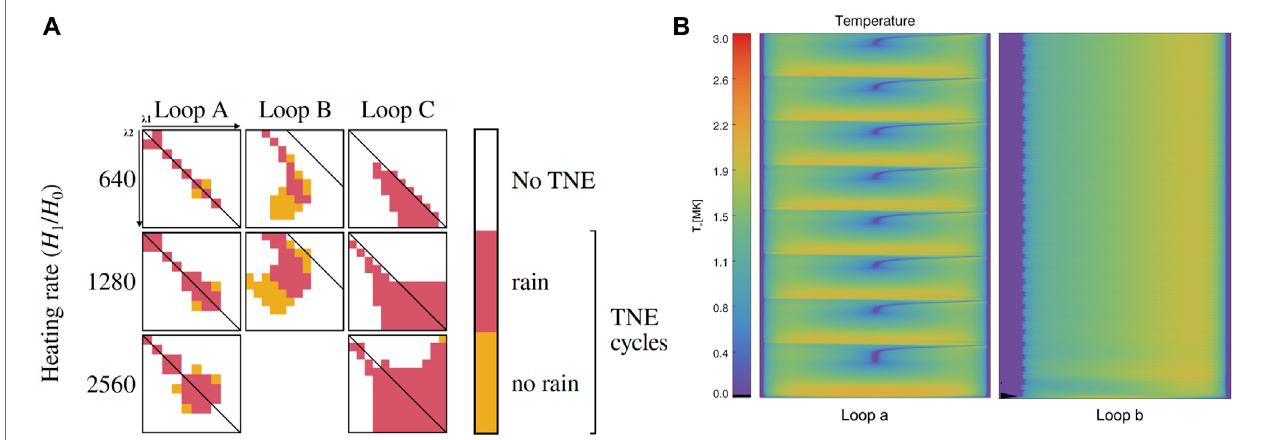
FIGURE2 | Left: (A) This fi gure isadapted from Figure 7 ofPelouze et al.(2022). Itshows the parameter spaceexplored inthe simulationsofFroment et al. (2018). Three loops geometry were considered for an extensive heating rate and scale height scan using 1D hydrodynamic simulations. Each big square represents a set of simulations, the heating scale heights for each loop leg is varying on the x -axis ( λ 2 ) and y -axis ( λ 1 ) and from the top-left to the bottom-right. These variations are ranging from 2% to 18% of the three loop lengths. Each small square corresponds to one simulation. The diagonal line shows the cases where λ 1 = λ 2 , i.e. symmetric heating cases. Loop A was a semicircular loop with L = 367 Mm, while Loop B and Loop C were geometries coming from magnetic fi eld extrapolations. Loop B is strongly asymmetric with L = 367 Mm and Loop C moderately asymmetric with L = 137 Mm. Here the heating rate H 1 / H 0 corresponds to H base / H background . (B) Figure adapted fromtheresults ofFromentet al.(2018),both simulationshave λ 1 = λ 2 =29.4Mm, L =367 Mm, H 1 =6.4 ×10 – 5 W m − 3 ,ontheleft withgeometry ofLoop A, on the right thatof Loop B. The samecolor scale isused for the temperature.The x and y -axis represent, respectively, the positionalongthe loop length and 3 days of loop